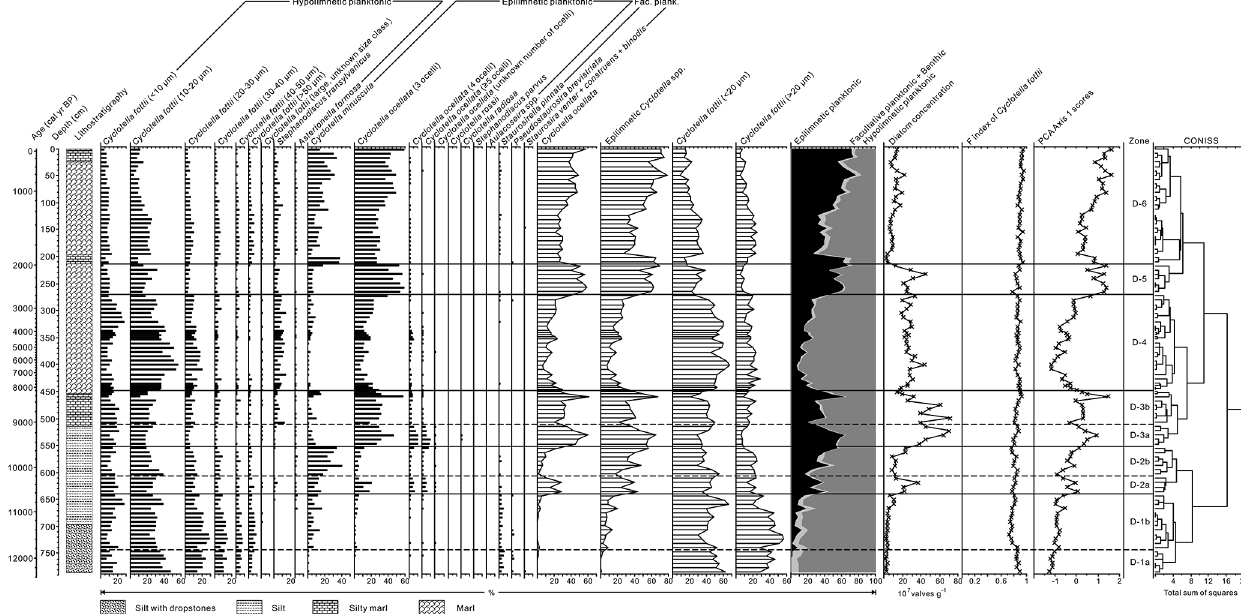
Figure 3. Summary diatom diagram of relative abundance of planktonic and facultative planktonic species from core Co1262, showing lithostratigraphy (modified from Wagner et al., 2012), diatom concentration, C. fottii F index values, and principal component analysis (PCA) Axis 1